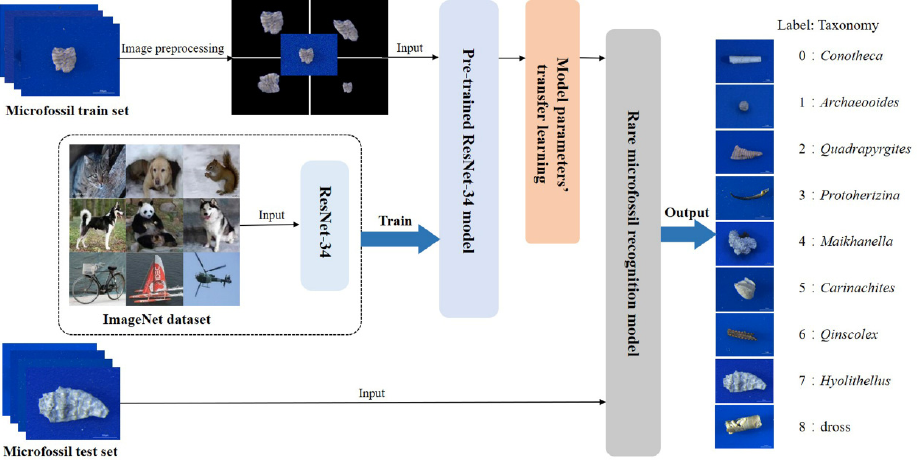
Figure 3. Rare microfossil recognition model based on transfer learning and ResNet-34.